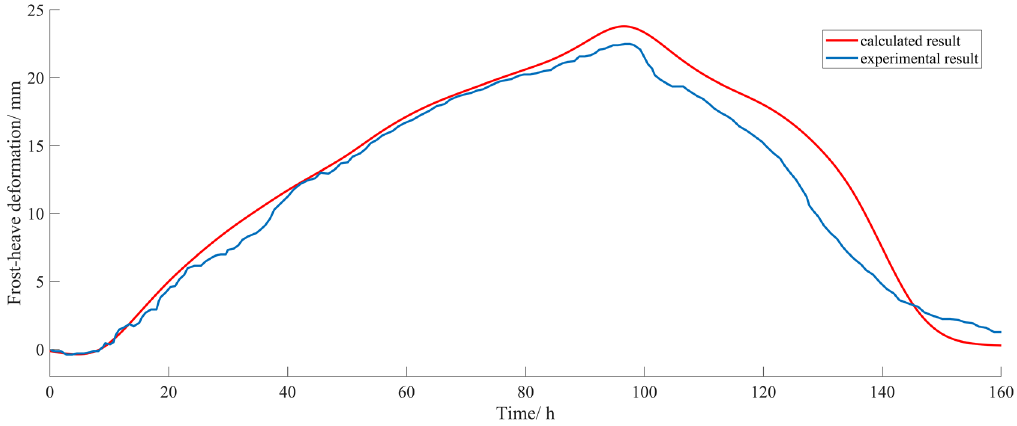
Figure 11. Time-history curves of the frost heave deformation at the top of the canal.